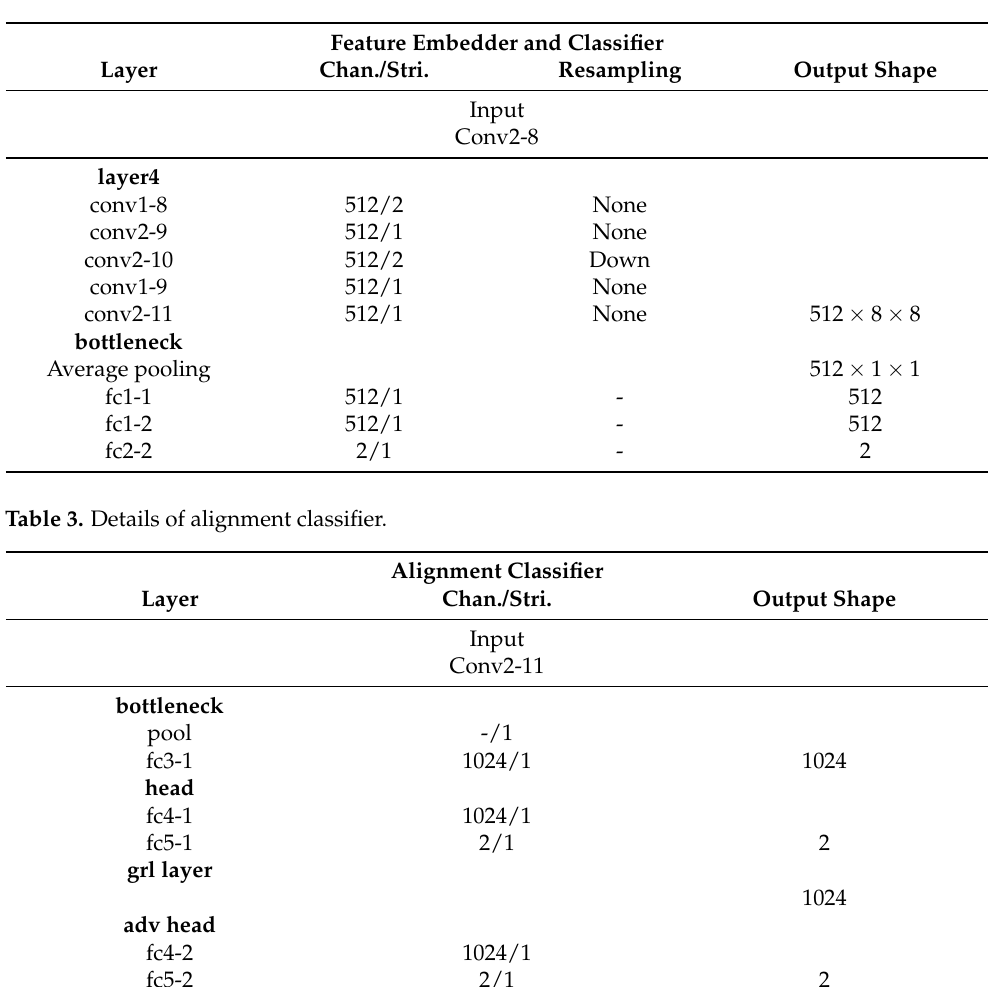
Table 2. Details of feature embedder and classifier.